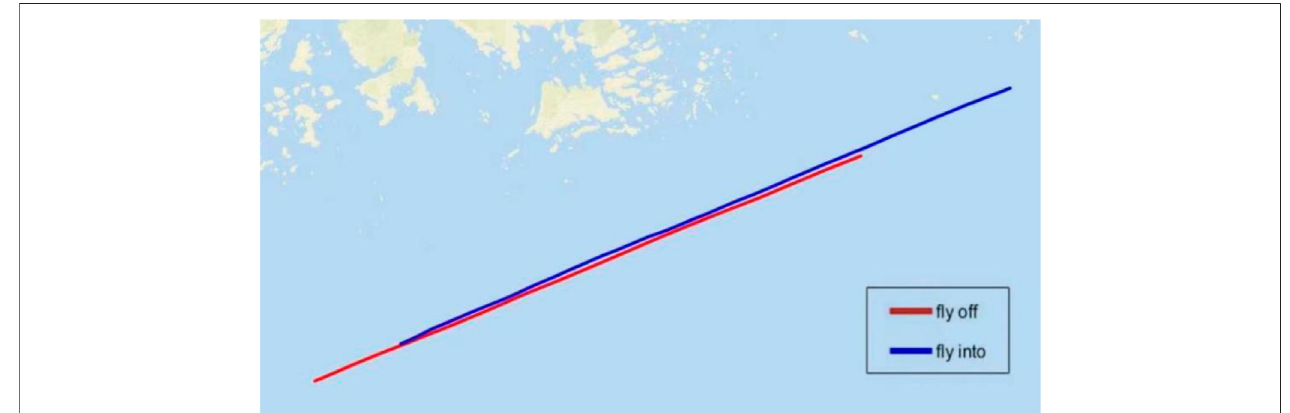
FIGURE 3 | Flight trajectory diagram.